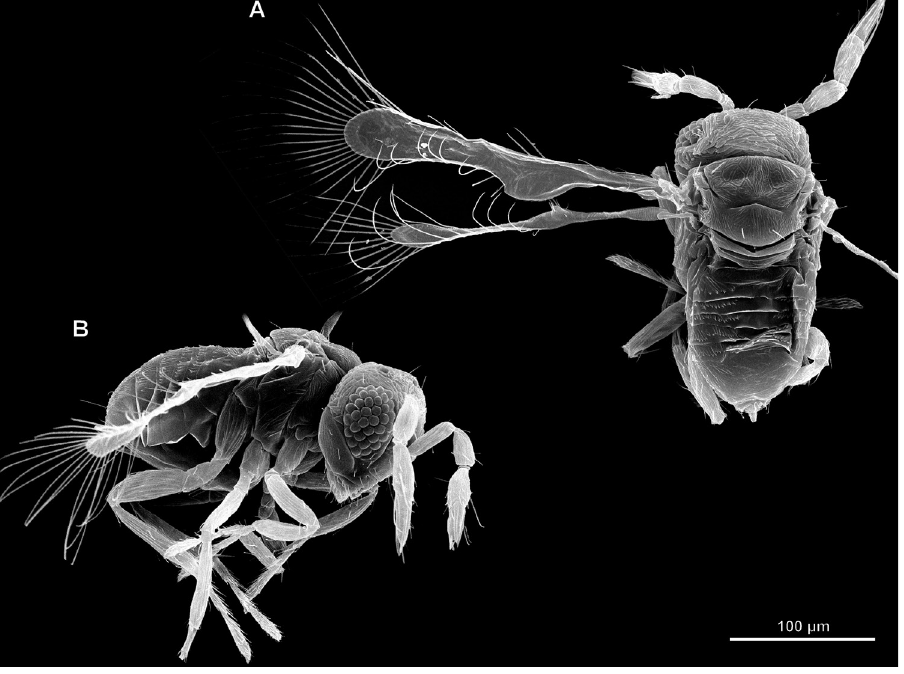
Figure 1. Habitus of Megaphragma caribea , SEM: A dorsal view B lateral